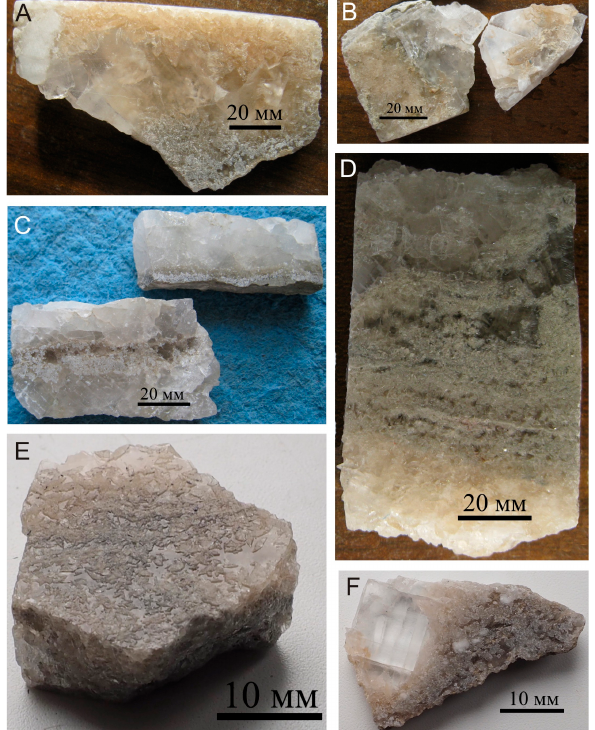
Figure 6. ( A ) Yellowish–beige glauberite in secondary halite, white-colored nodular anhydrite (left part), sample No. 10; ( B ) Sedimentary halite deposited after the formation of glauberite, sample No. 9; ( C ) A layer of fine-grained anhydrite in sedimentary halite, sample No. 4; ( D ) Sedimentary halite (in the upper part); greenish–grey clay-enriched interlayers with radial overgrowths of glau- berite and tiny pores are filled with halite (in the central part), light glauberite layer in the form of isometric crystals and large pores and caverns are filled with halite (in the lower part), sample No. 12; ( E ) Pores and caverns in the glauberite layer are filled with secondary halite. Pores and caverns formed after finely dispersed gypsum or sodium syngenite dissolution, sample No. 12; ( F ) A layer of glauberite with residual white anhydrite and secondary halite. Glauberite growth occurred from solutions around the crystallization centers, represented by gypsum, sample No. 9. For Sam- ple location, see Figure 2 and Tables